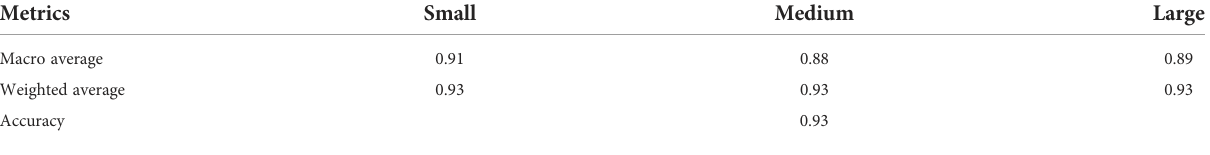
TABLE 5 Final predicted results of the classi fi cation.